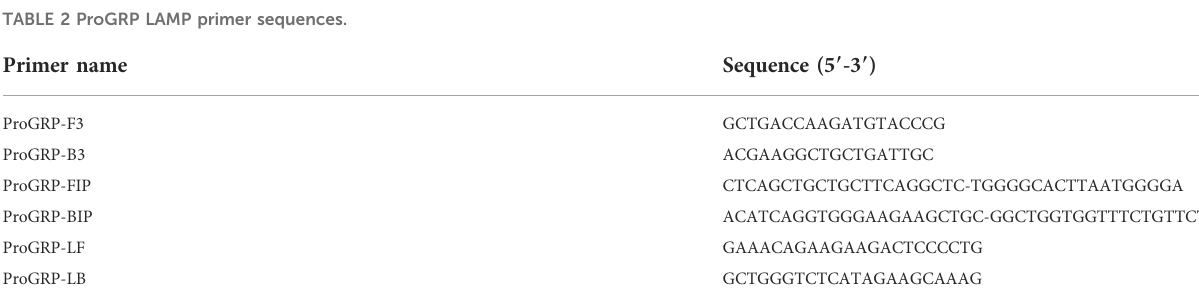
TABLE 2 ProGRP LAMP primer